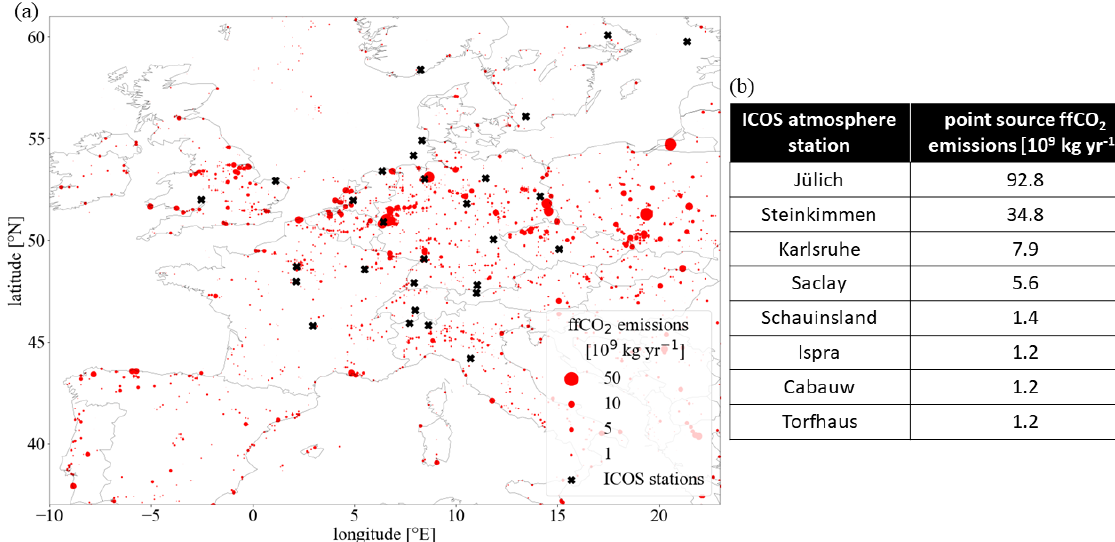
Figure 1. (a) European ffCO 2 point source emissions according to Super et al. (2020, red dots) and the locations of ICOS atmosphere class-1 and class-2 stations (black crosses). (b) ICOS atmosphere stations with a total of more than 1 million tonnes of ffCO 2 emissions from point sources within a 50km × 50km box around the